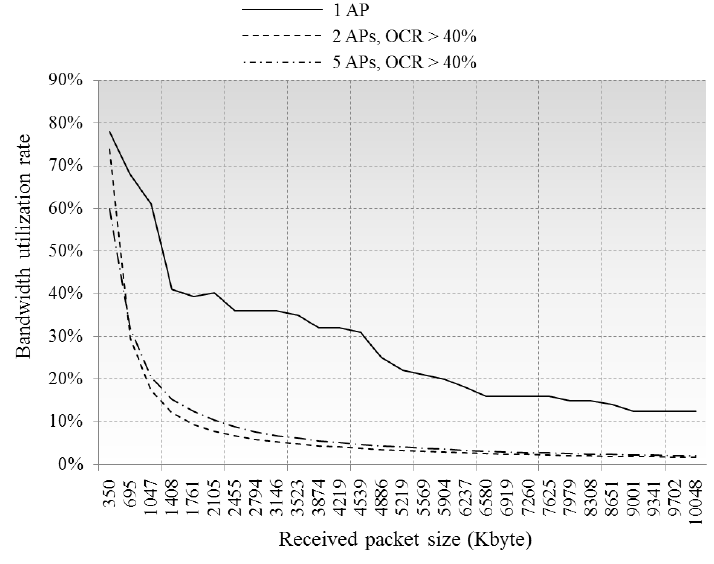
Figure 12. Comparison of bandwidth utilization